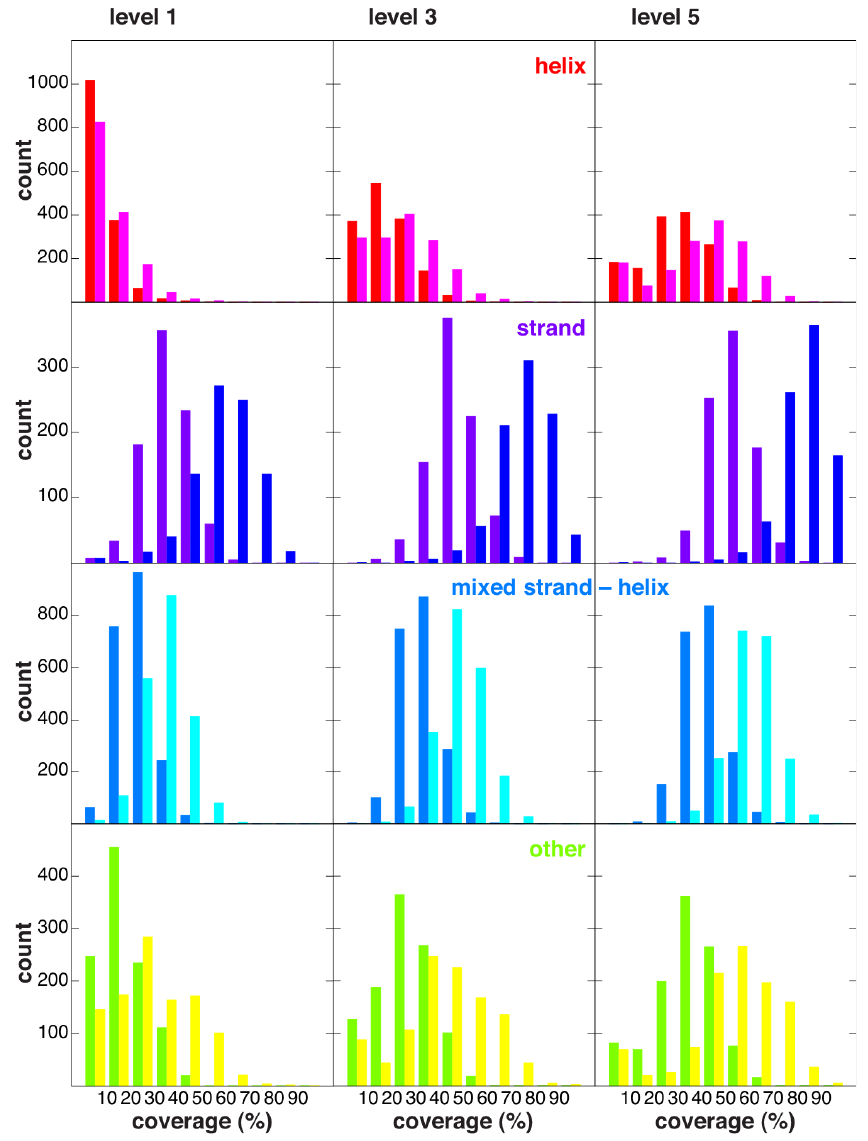
Figure 5. Chain coverage distributions. Coverage distribution for chains of different secondary structure classification with respect to all residues/helix and strand residues only, at different RMSD cutoff values (level 1, level 3 and level 5 from left to right, as defined in Table 1) of each RSM type. For helix-class chains, the coverage is shown for all residues (in red) and for helix and strand residues only (in magenta). For strand-class chains, the coverage is shown for all residues (in purple) and for helix and strand residues only (in dark blue). For mixed strand-helix-class chains, the coverage is shown for all residues (in blue) and for helix and strand residues only (in cyan). Finally, for other-class chains, the coverage is shown for all residues (in green) and for helix and strand residues only (in